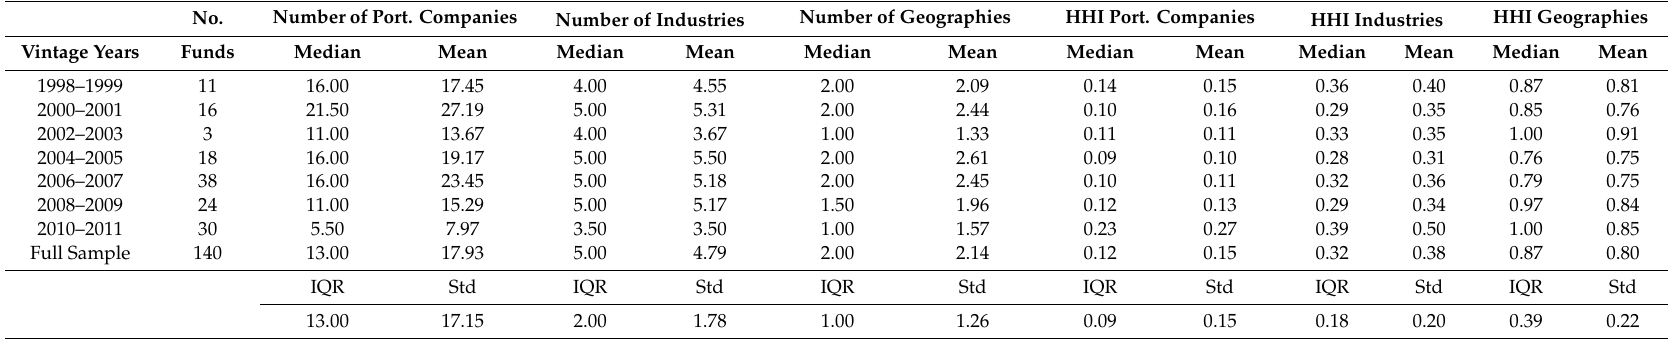
Table 3. Characteristics of diversification